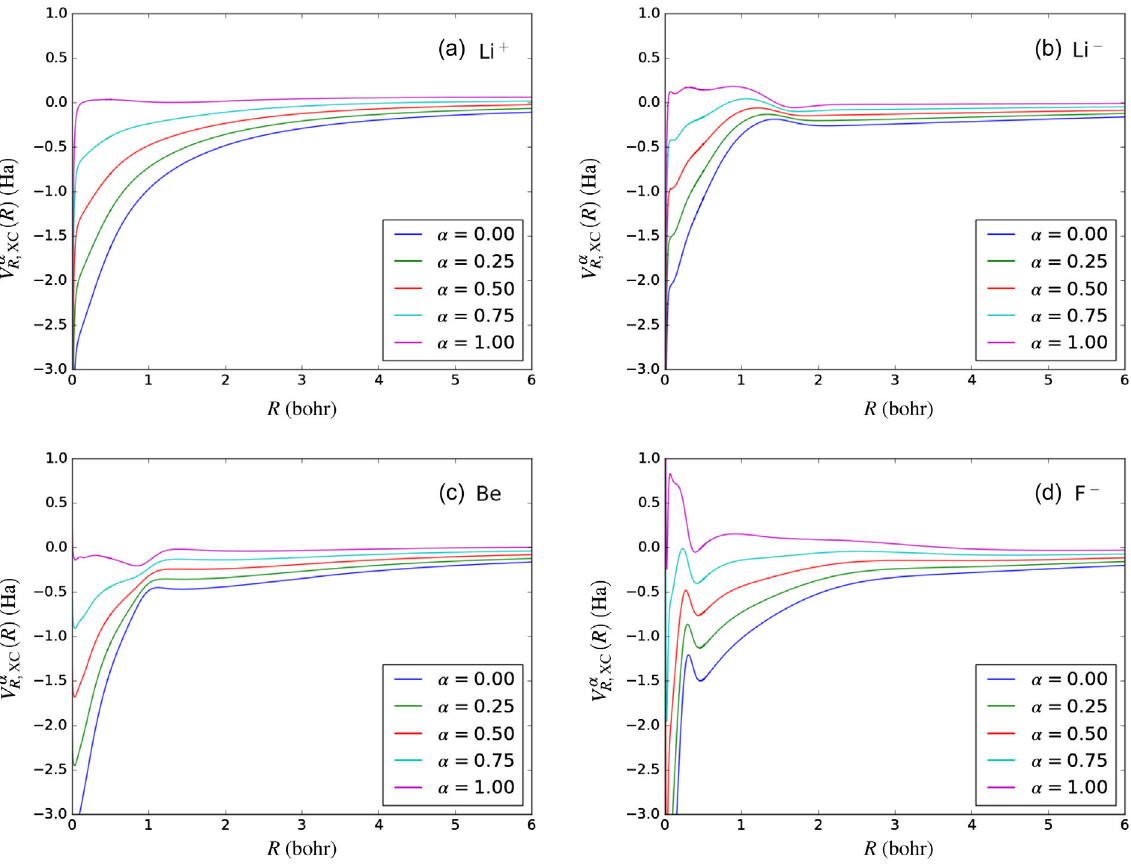
FIG. 2. Exact remainder exchange-correlation potentials V α exchange for (a) Li þ (b) Li − , (c) Be, and (d) F −